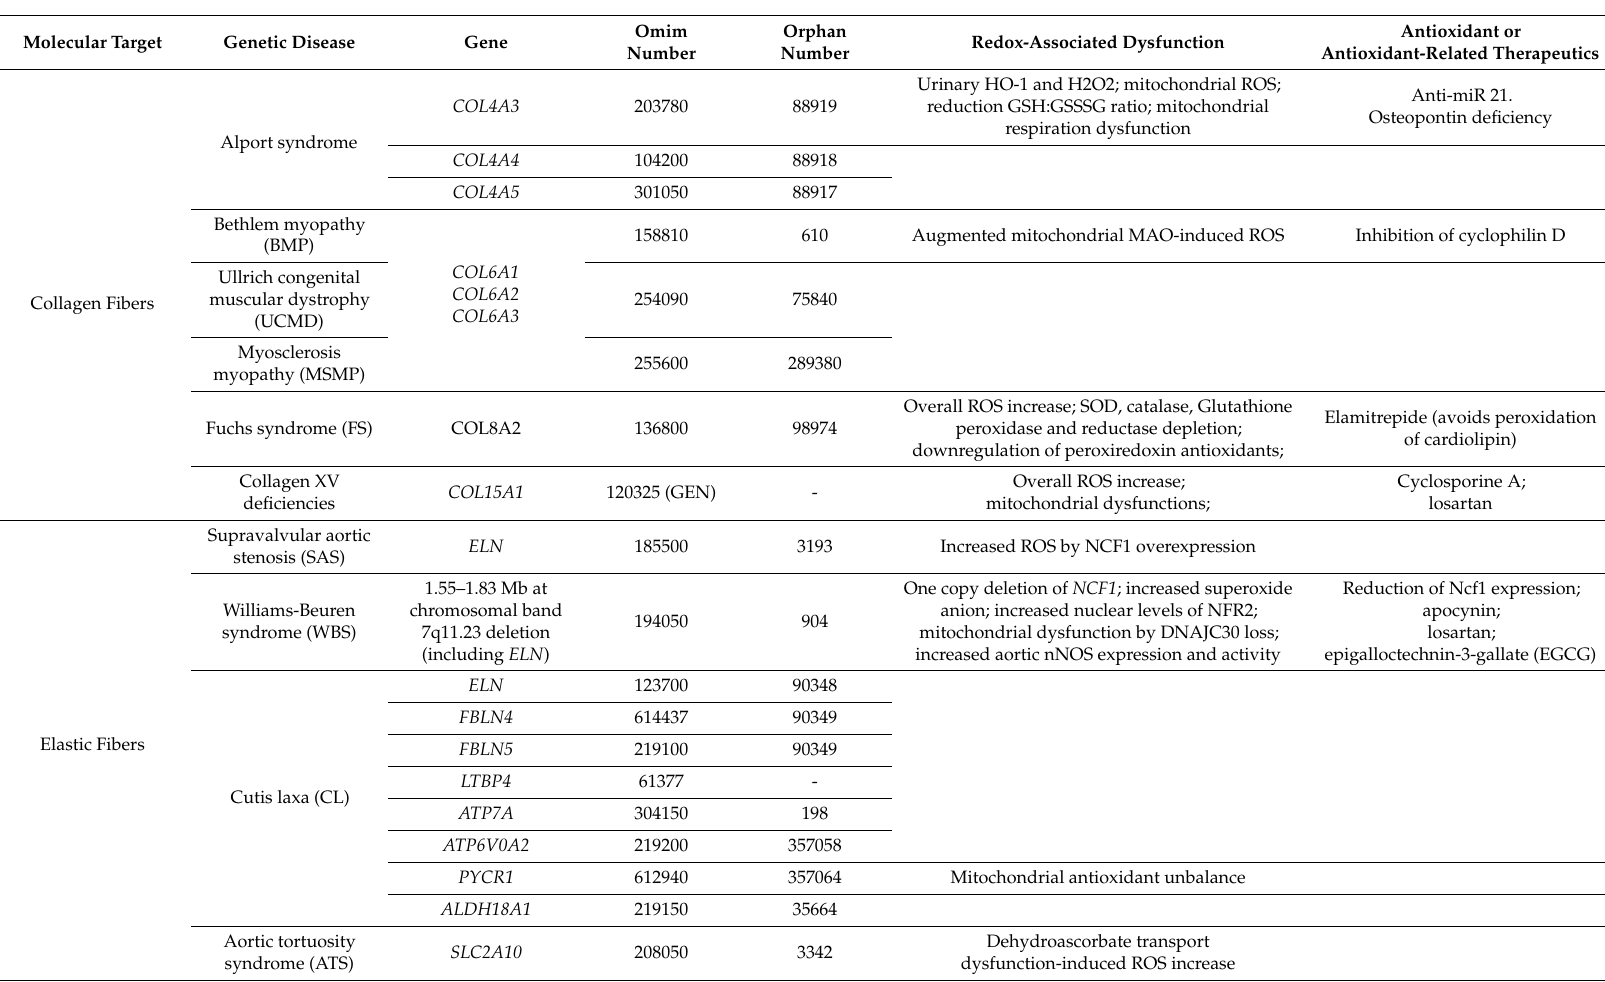
Table 1. Summary of the genetic diseases in which connective tissue molecular components are a ff ected, their causative gene with OMIN and ORPHAN numbers, the radical species involved and reported therapeutic